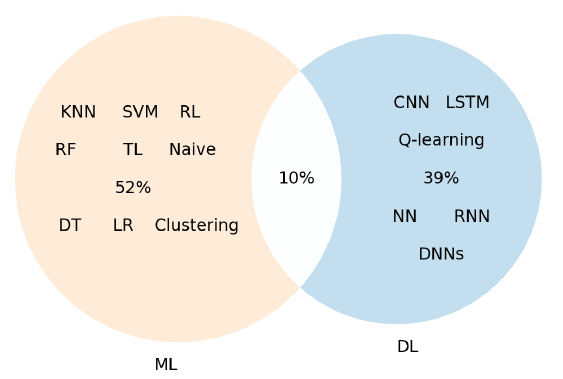
Figure 24. Overview of ML and/or DL techniques that have been used in the included papers.